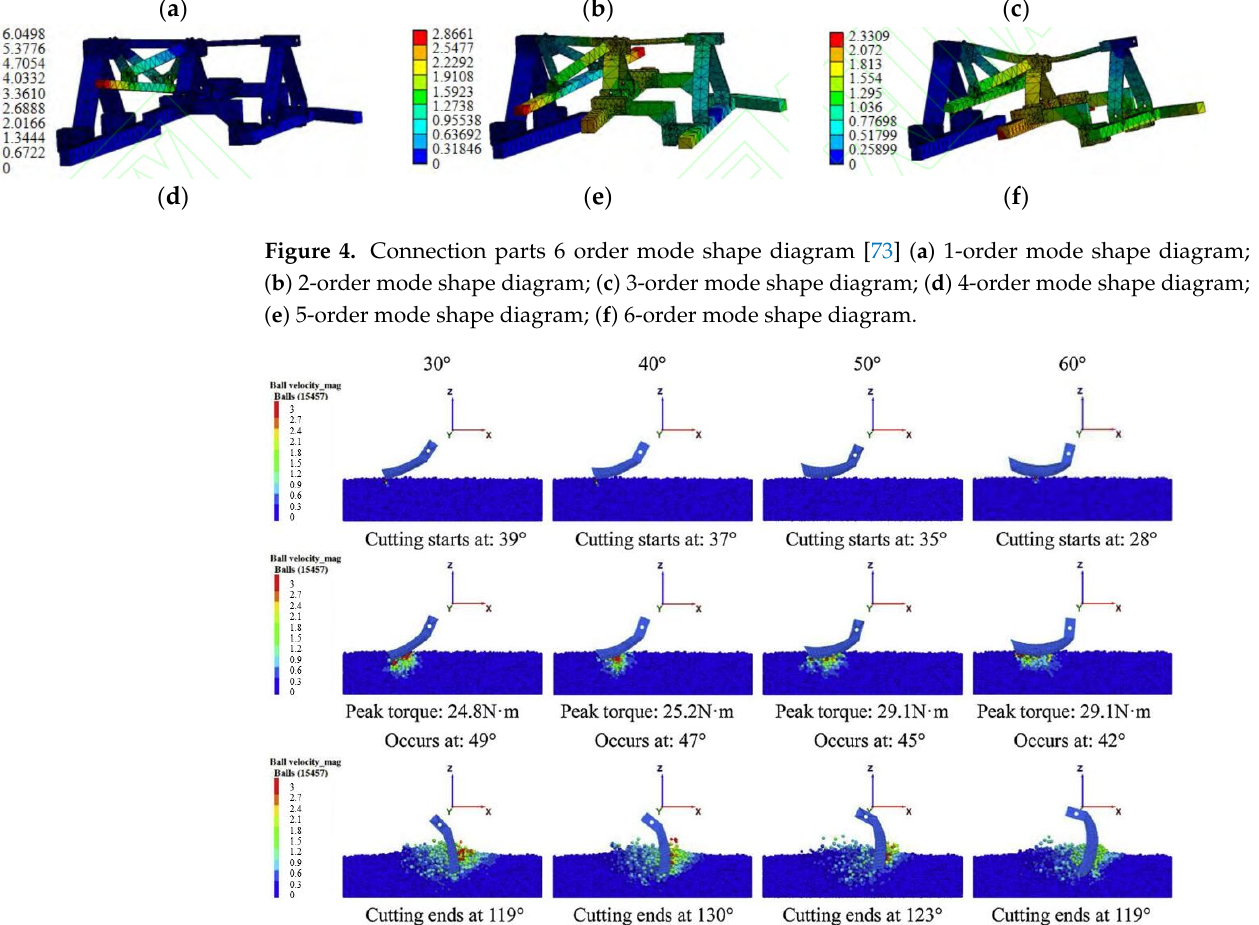
Figure 5. Variation in torque and blade position of the Archimedean spiral blade [57].